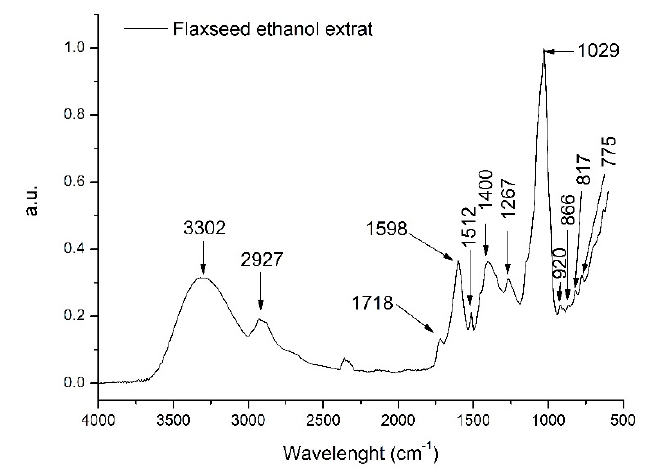
Figure 2. Flaxseed ethanolic general FTIR spectra (3500–500 cm − 1 ).